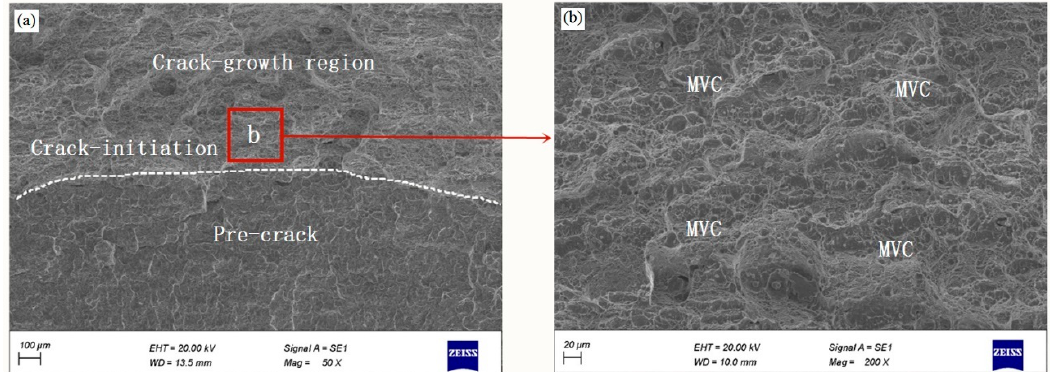
Figure 4. ( a ) Scanning electron microscopy (SEM) images of the fracture surface for uncharged specimen, and ( b ) SEM high magnification image of the indicated region in ( a ).